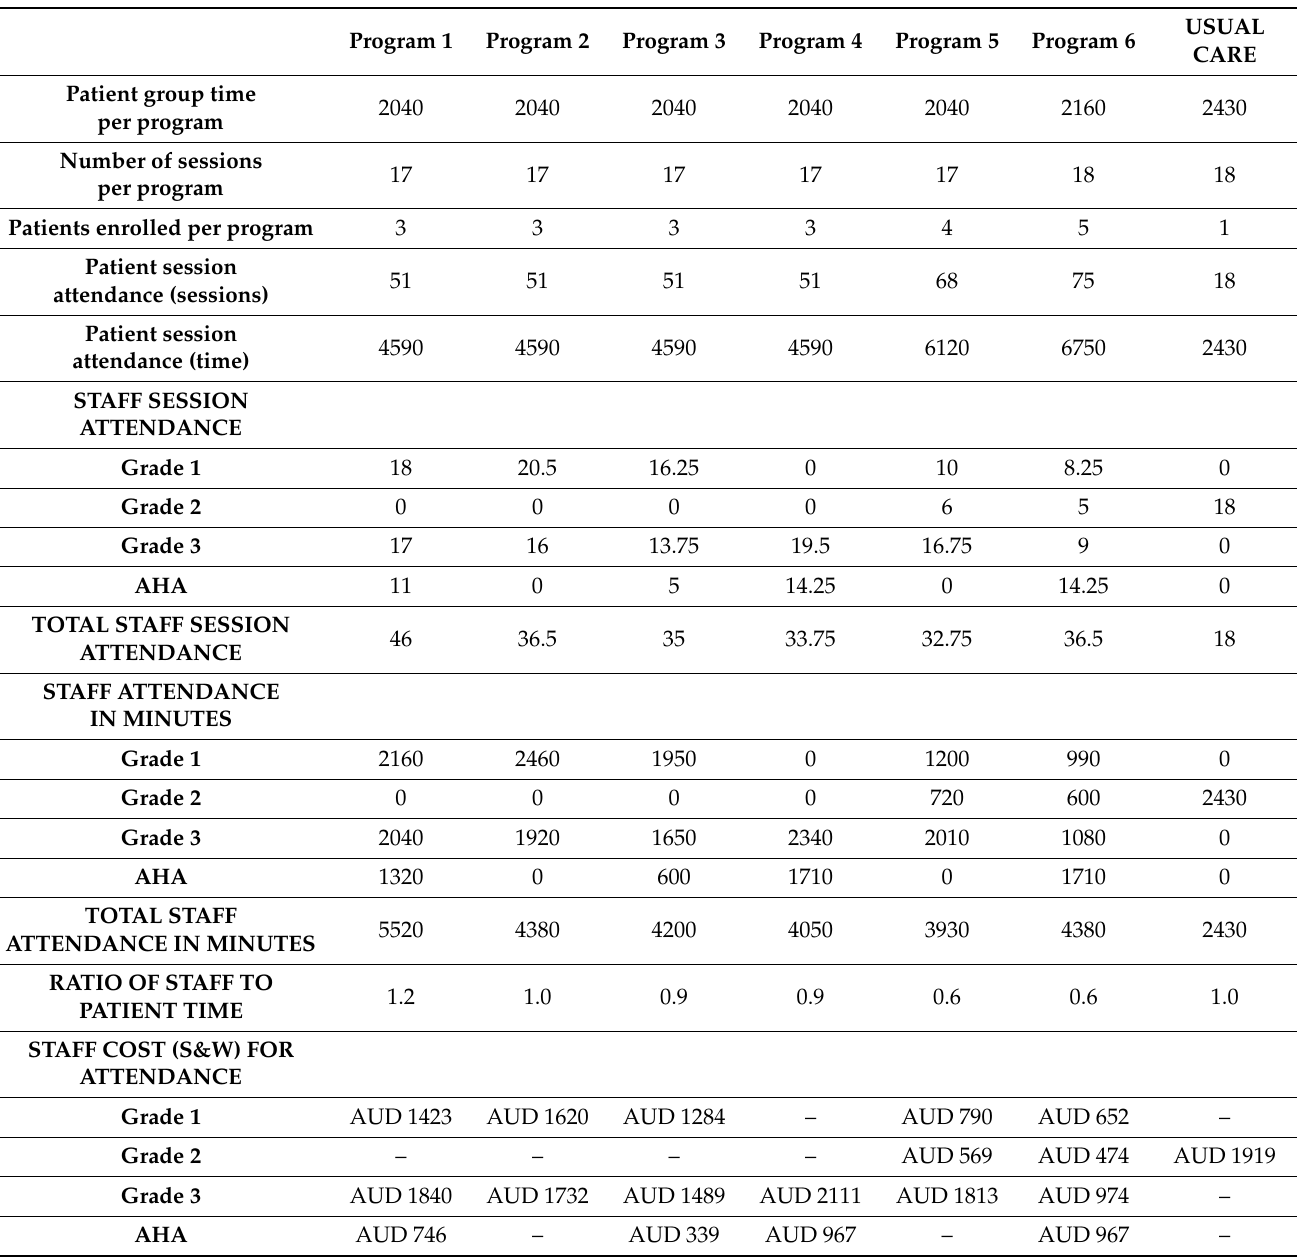
Table 8. Staff costs for each of the 6 RBT programs and for usual